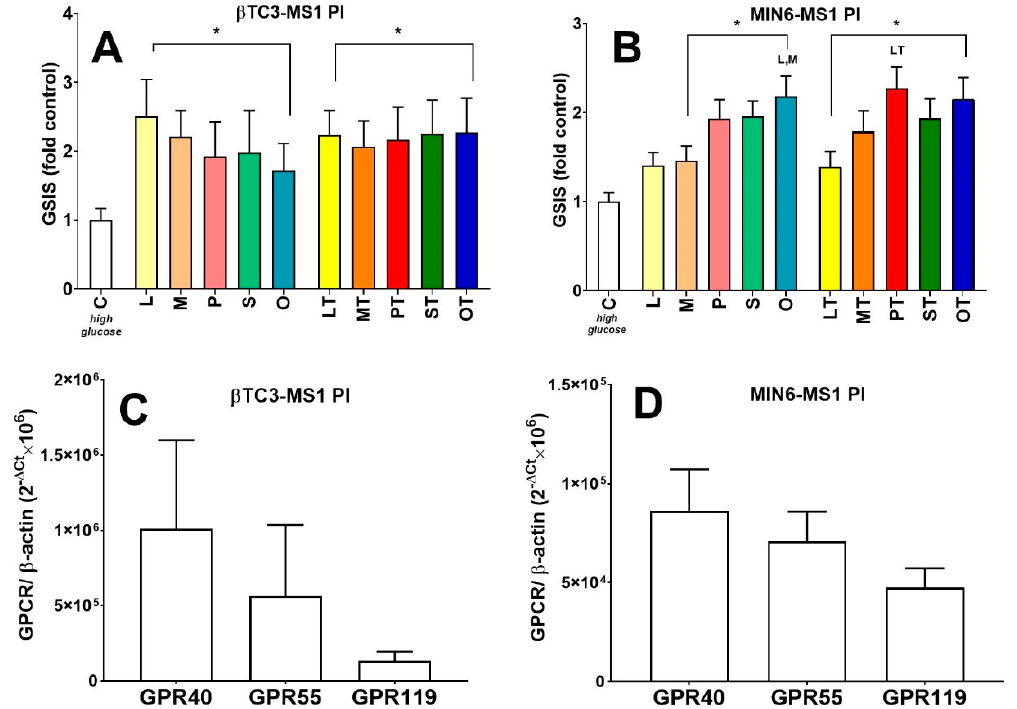
Figure 6. The potentiatory effect on GSIS of native LPCs (L, M, P, S, O) and their phosphorothioate analogues (LT, MT, PT, ST, OT) in β TC3-MS1 ( A ) and MIN6-MS1 PIs ( B ) in comparison to GPR40, GPR55, and GPR119 expression patterns in these PIs ( C : In β TC3-MS1; D : In MIN6-MS1). GSIS experiments stimulated with native and modified LPCs are presented for 20 mM glucose conditions. For the p-value less than 0.05 results are regarded as significantly different from control (high glucose) conditions ( C ) * or from the corresponding native LPC + . Statistically significant difference was also assessed between compounds bearing acyl chains of different lengths (either within native or synthetic compound groups), and p < 0.05 was depicted by a compound abbreviation.